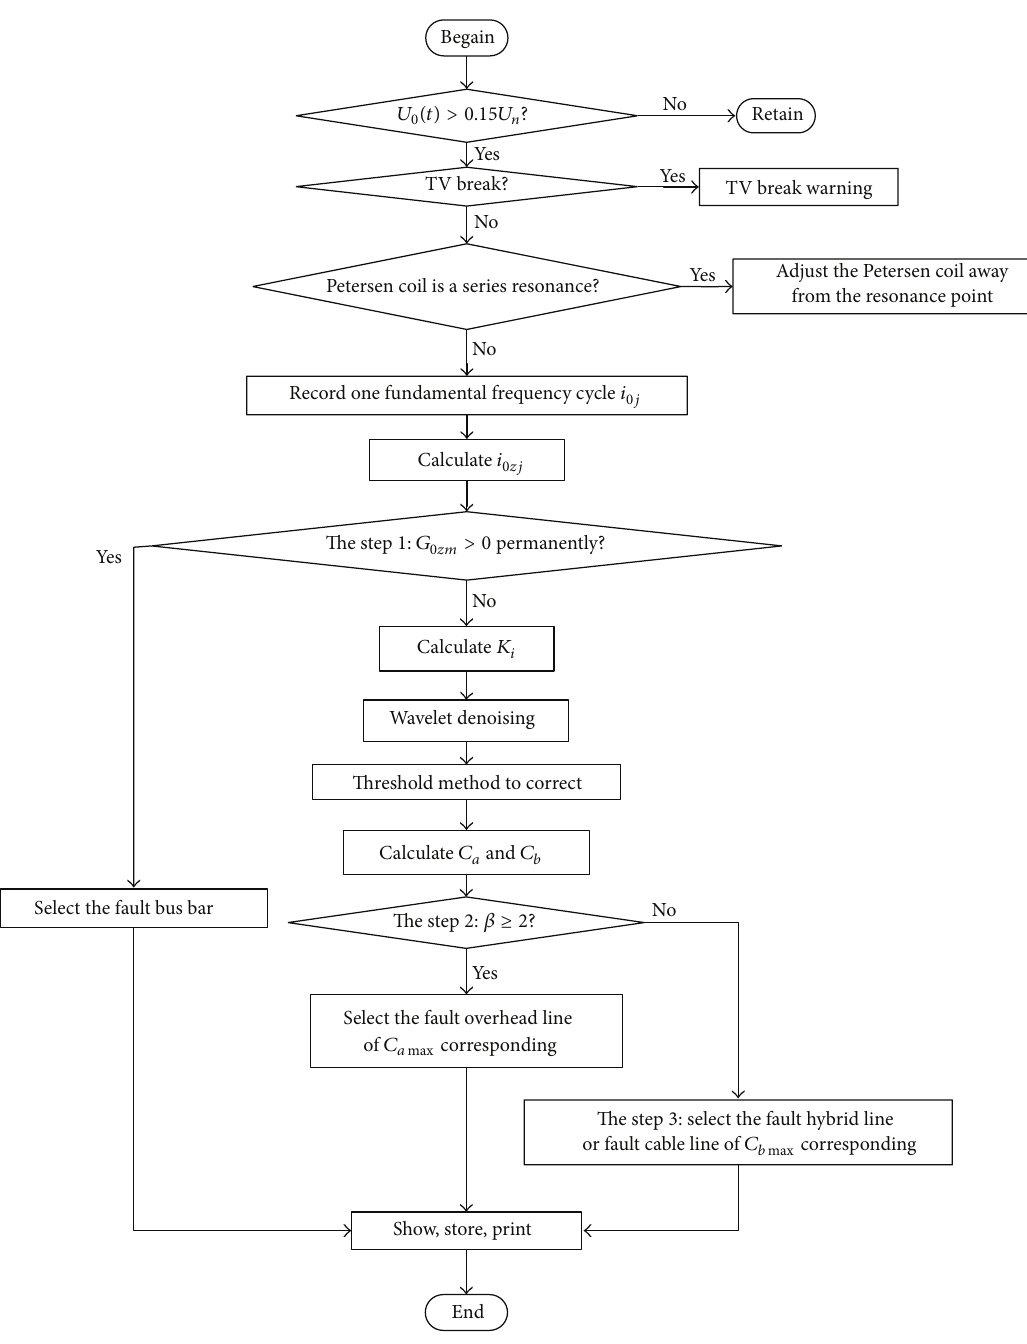
Figure 4: Flowchart of fault line